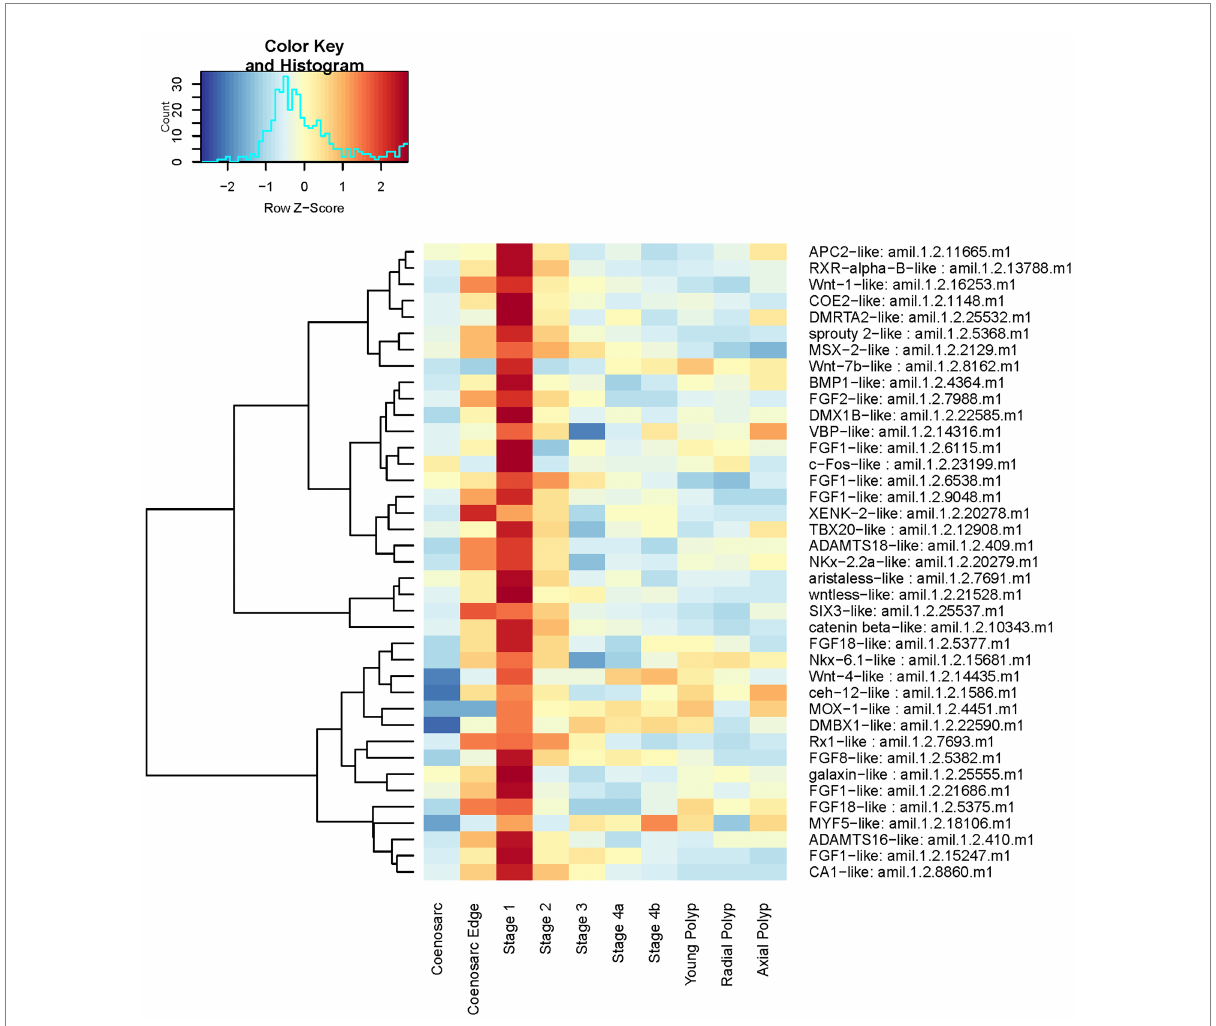
FIGURE 6 Expression heatmap of selected genes among those highly upregulated at regeneration Stage 1. Samples were pooled according to regeneration stage and colony part. Colour denotes an increase (red) or decrease (blue) in expression based on the z-score. The Histogram shows the distribution of the z-scores on the